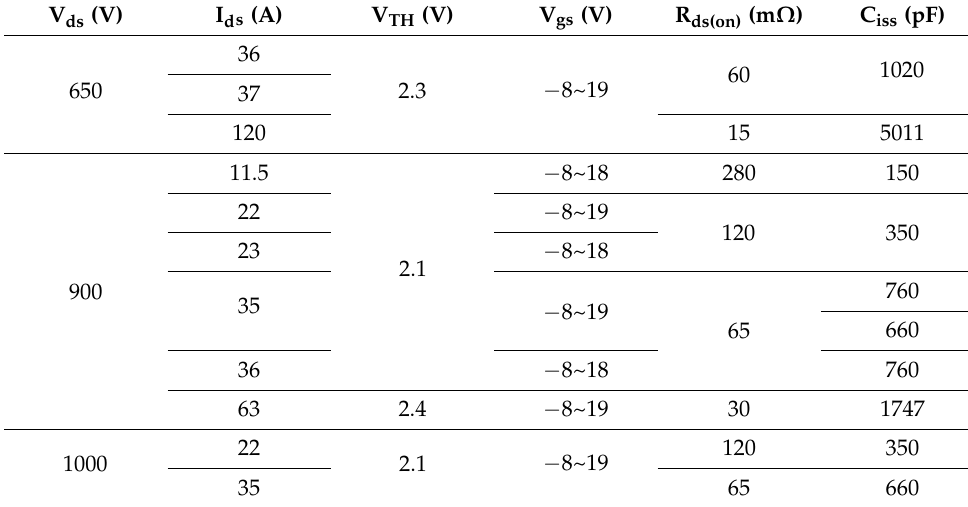
Table 7. Commercial600~1200 V SiC MOSFETs by